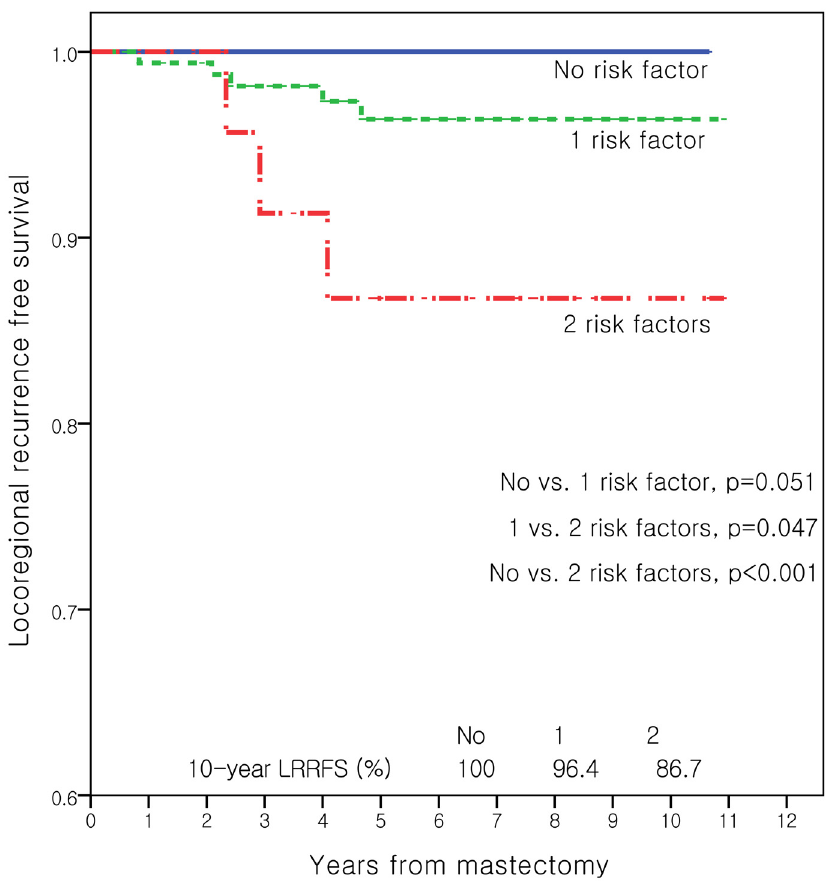
Fig 2. Kaplan-Meier curves for locoregional recurrence free survival (LRRFS) according to the number of risk factors in pN0 patients. Risk factors are age under 50 years and no use of adjuvant